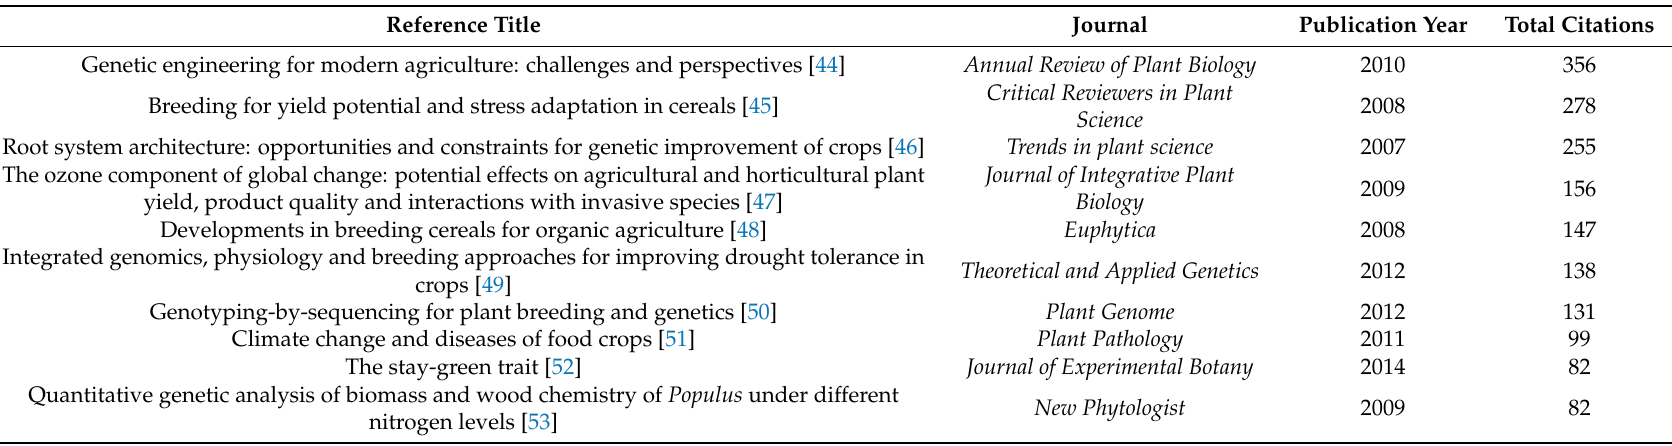
Table 1. Top ten list of the most cited scientific articles retrieved (up until 11/8/2018) from the Web of Science database, category “Plant science”, using the following query: ([(“plant breeding”) AND (“climate change*”)] OR [(“association mapping”) AND (“climate change*”)] OR [(“gwas”) AND (“climate change*”)] OR [(“genomic selection”) AND (“climate change*”)] OR [(“mutagenesis”) AND (“climate change*”)] OR [(“QTL*”) AND (“climate